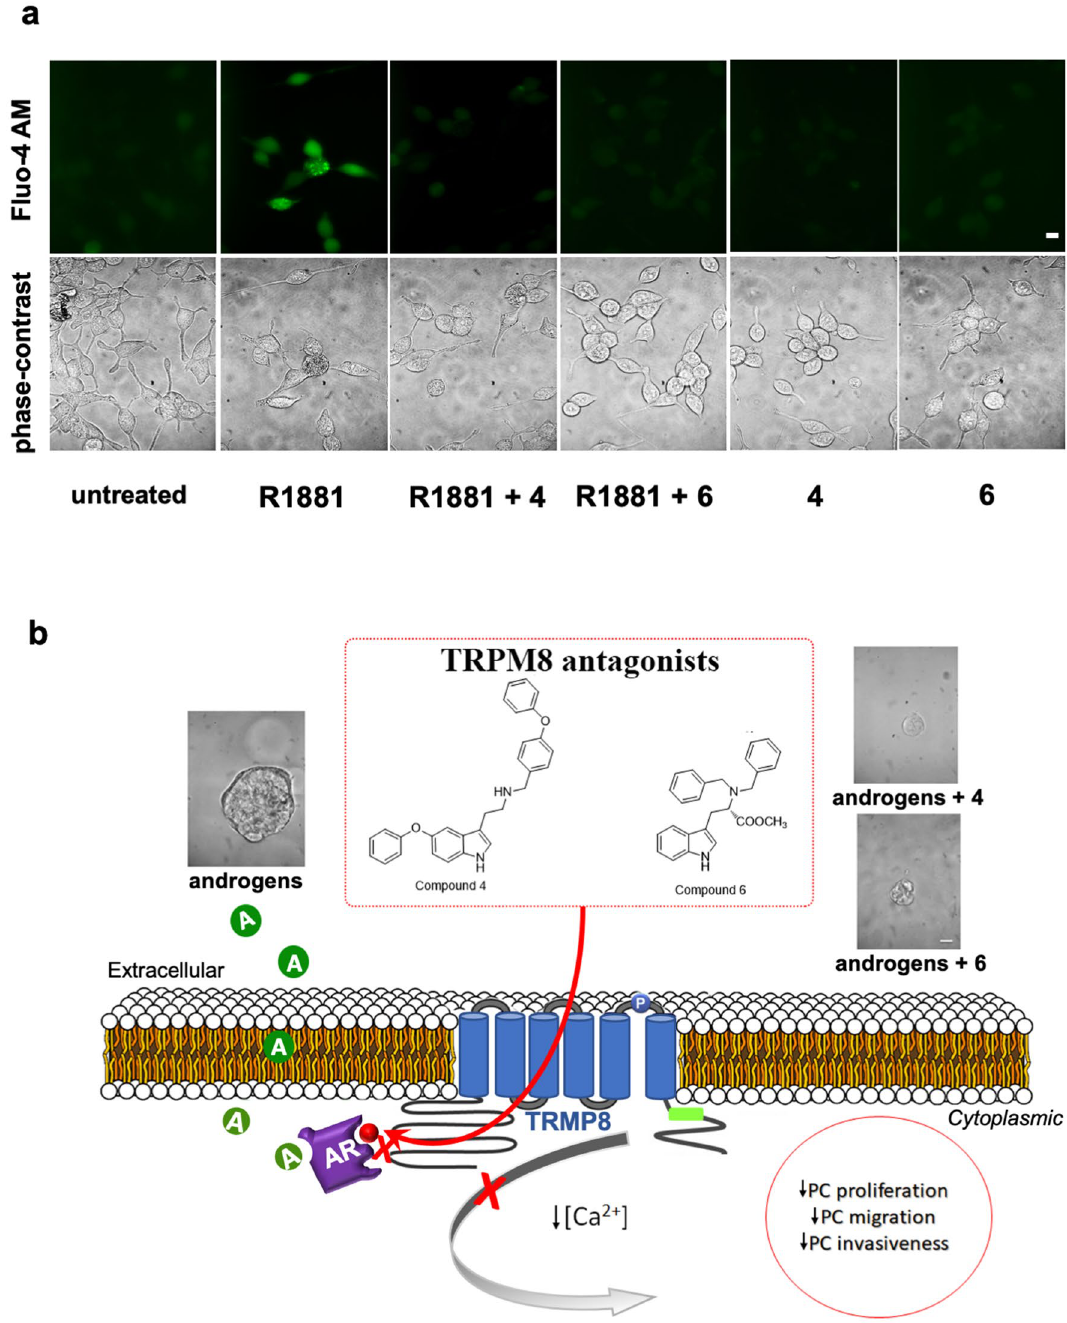
Figure 7. TRPM8 antagonists inhibit the androgen-induced increase of intracellular Ca 2+ levels in LNCaP cells. In ( a ), LNCaP cells were made quiescent and loaded with 1 µM 4-Fluo AM, as described in “Methods”. Cells were left untreated or treated for 240 s with 10 nM R1881, in the absence or presence of the indicated compounds (at 1 μM). Different fields were analyzed by fluorescence (upper images) or phase-contrast (lower images) microscopy, as described in “Methods”. Representative images were acquired using a DFC 450C camera (Leica). Bar, 10 μM. In ( b ), the mechanism of TRPM8 antagonist action in PC cells is shown. Androgens rapidly induce association of AR with TRPM8 in androgen-sensitive PC cells. Once assembled, this complex leads to intracellular calcium increase and promotes proliferation as well as pro-metastatic phenotype of PC cells. By perturbing the androgen-challenged AR/TRPM8 complex assembly, TRPM8 antagonists (compounds 4 and 6 ) lower the intracellular calcium levels and impair the proliferation, invasion and growth in 3D of PC